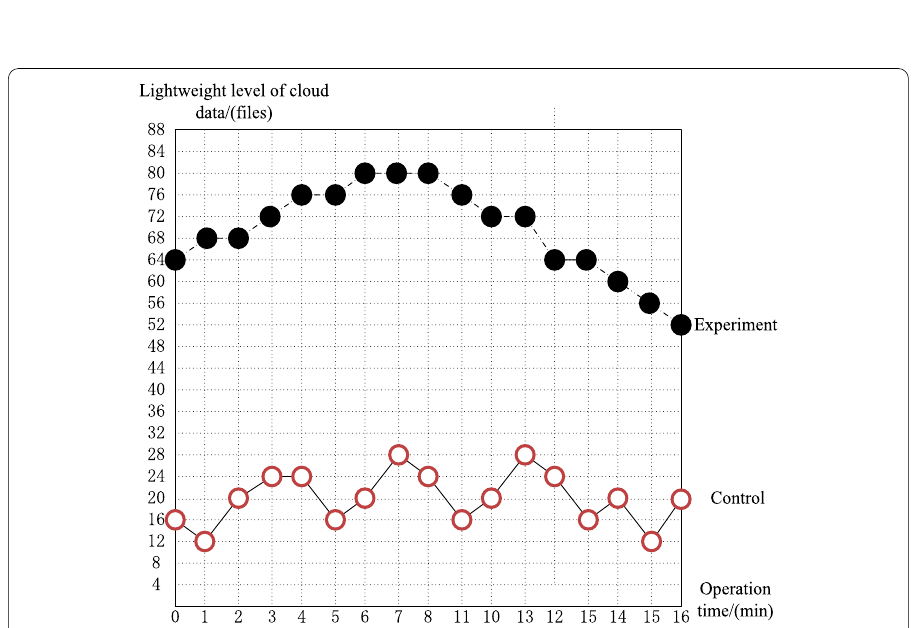
Fig. 6 Comparison of lightweight level of cloud data (operating status of middle mechanical